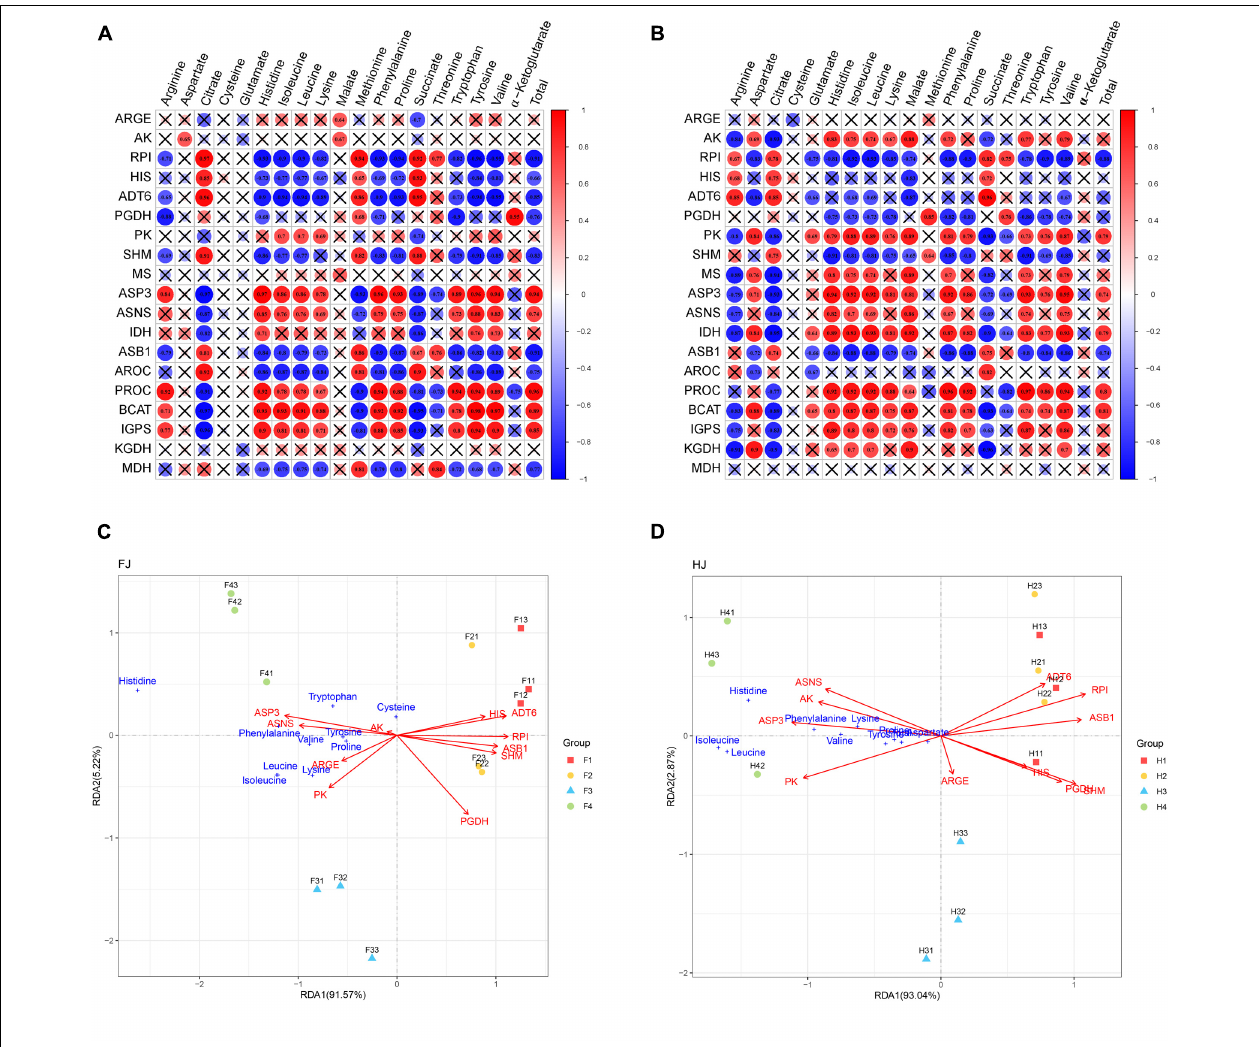
FIGURE 7 | Correlation analysis and redundancy analysis (RDA) of amino acids and synthetic genes in amino acid biosynthesis pathway. (A,B) Intergroup analysis of amino acids and synthetic genes in FJ and HJ, respectively. (C,D) RDA of amino acids and synthetic genes in FJ and HJ,